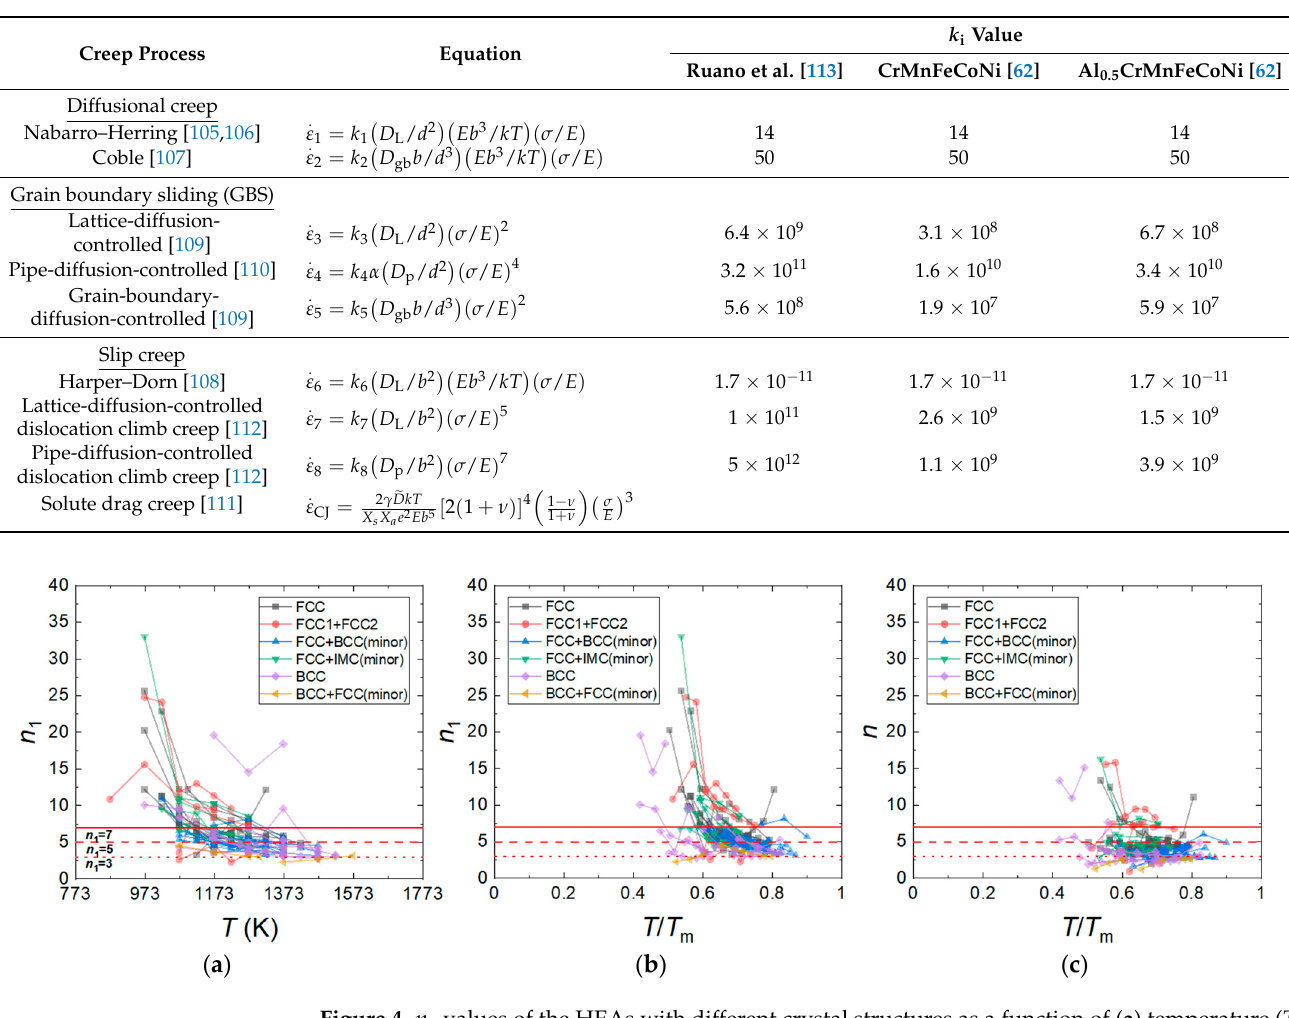
Figure 4. n 1 values of the HEAs with different crystal structures as a function of ( a ) temperature ( T ) and ( b ) homologous temperature ( T / T m ). ( c ) n values of the HEAs as a function of T / T m . . ε − log σ curves for the Al x CrMnFeCoNi Figure 5a,b shows the log ( x = 0–1) [9,27,34,42,63] and Al x CrFeCoNi ( x = 0–1) HEAs [13,25,51,53,72,84,92,96] at a given temperature of 1173 K. The n 1 value decreases from 5 to ~3 as x increases. This result indicates that as the amount of BCC phase (rich with Al) increases, the characteristics of viscous glide creep associated with n 1 ~3 become more pronounced. Jeong and Kim [42] analyzed the deformation behavior of the AlCrMnFeCoNi HEA and found that aluminum, which is largest in size among the constituent elements [42], acts as a solute that causes solute drag creep and showed that the solute drag creep model proposed by Hong and Weertman [111] for conventional metals can quantitatively explain the deformation behav- ior of the AlCrMnFeCoNi HEA with reasonable assumptions on the diffusivity of Al in the HEA. From the plots in Figure 5a,b, it should also be noted that flow stress tends to decrease the added amount of Al increases especially at low strain rates, indicating that the BCC phase deforming under solute drag creep is weaker than the FCC phase deforming under dislocation climb